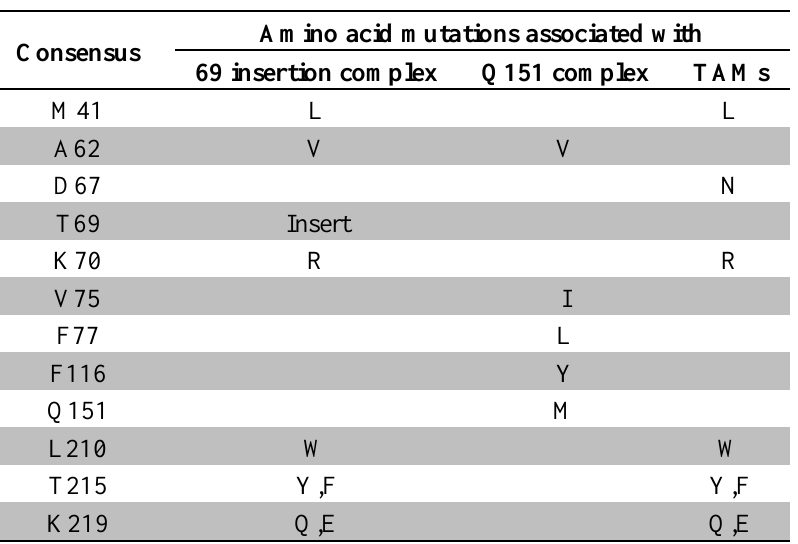
Table 2. Multidrug Resistance